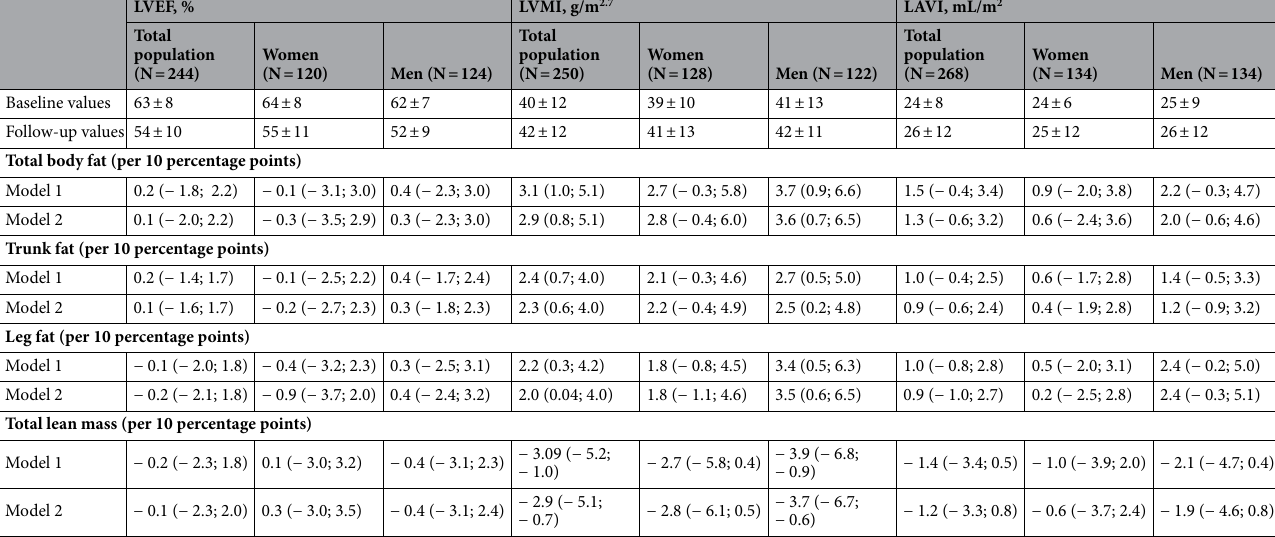
Table 2. Prospective associations of body composition measures with echocardiographic measures (LVEF, LVMI and LAVI). Unstandardized regression coefficients (95%CIs) are reported per ten percentage points increase of total body, trunk and leg fat, and total lean mass. Model 1 is adjusted for age, sex (for total population), glucose metabolism status at baseline and follow-up time. Model 2 is additionally adjusted for HbA1c, kidney function, hypertension status, history of CVD and smoking status, all measured at baseline. LVEF left ventricular ejection fraction, LVMI left ventricular mass index, LAVI left atrial volume